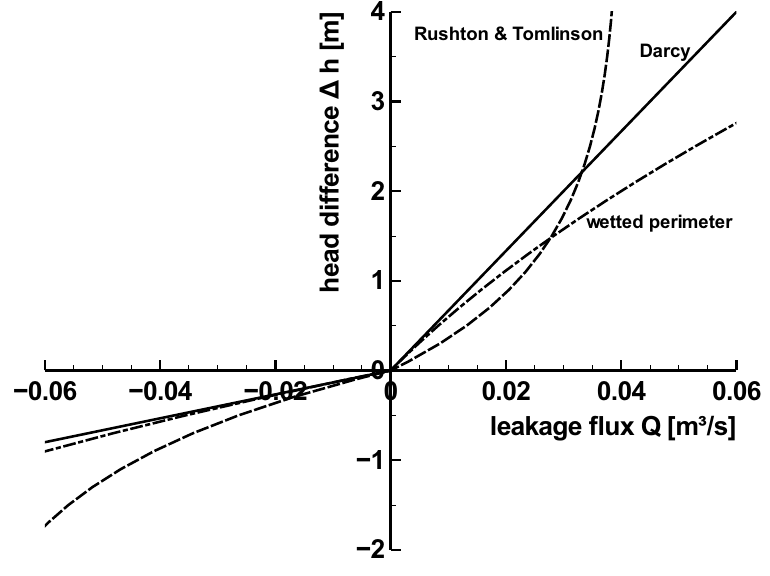
Figure 2. Leakage flux Q over head difference ∆ h for the Darcy leakage approach (Equations (4) and (6)), the approach by Rushton and Tomlinson [33] (Equation (9)) and the leakage approach that uses the wetted perimeter (Equation (8)), evaluated here with a trapezoidal